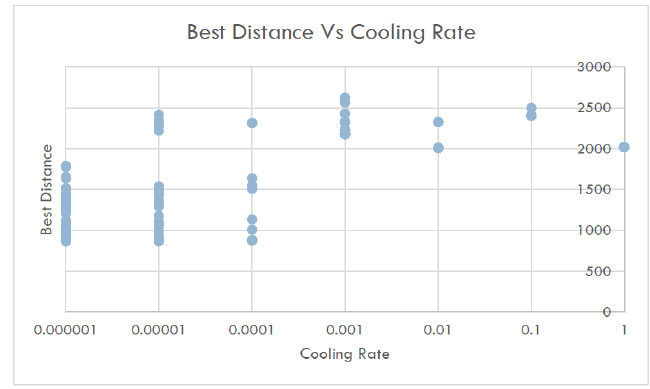
Fig. 7. Route Best Distances Compared to Cooling Rate